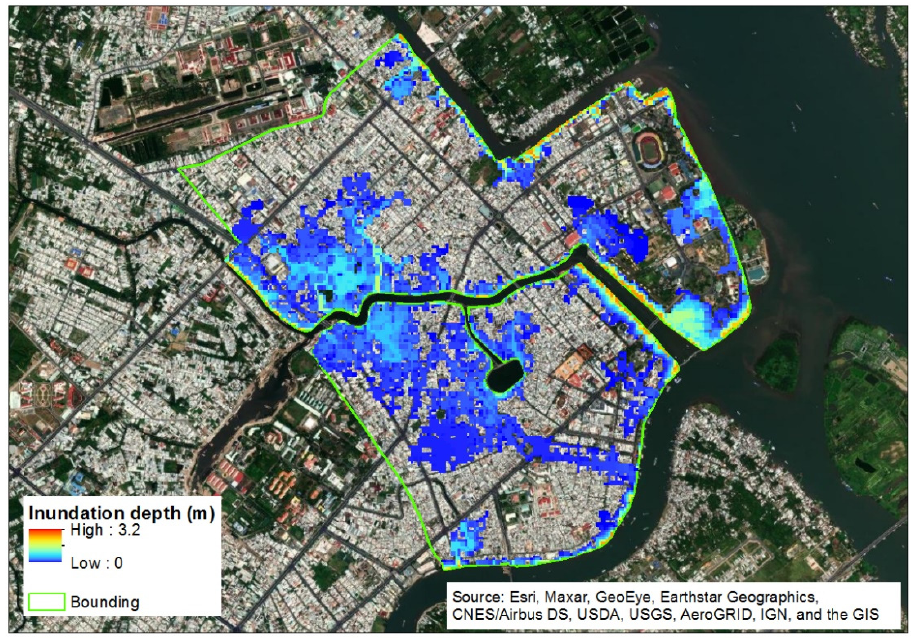
Figure 4. Inundation map corresponding to 100-year return period water level at Can Tho in the year 2050 under RCP 4.5.